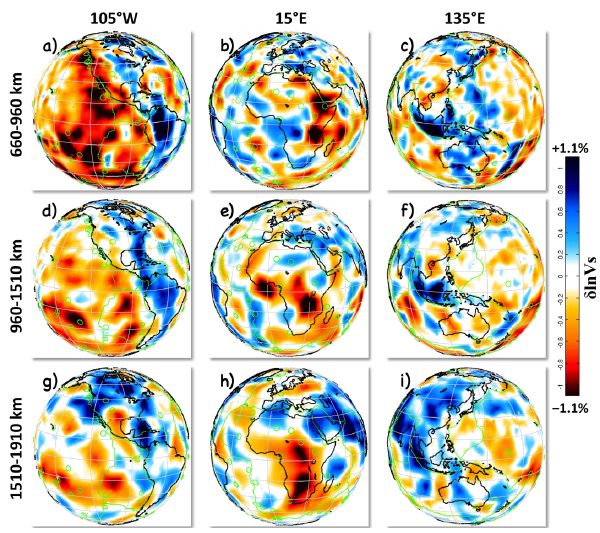
Fig. 6. Tomographic maps of shear-velocity anomalies of our model MB pref at selected depths in mid lower-mantle: 660– 960, 960–1510, and 1510–1910km depth. Black lines: continents; green lines: tectonic plates; green circles: hotspots (Anderson and Schramm,